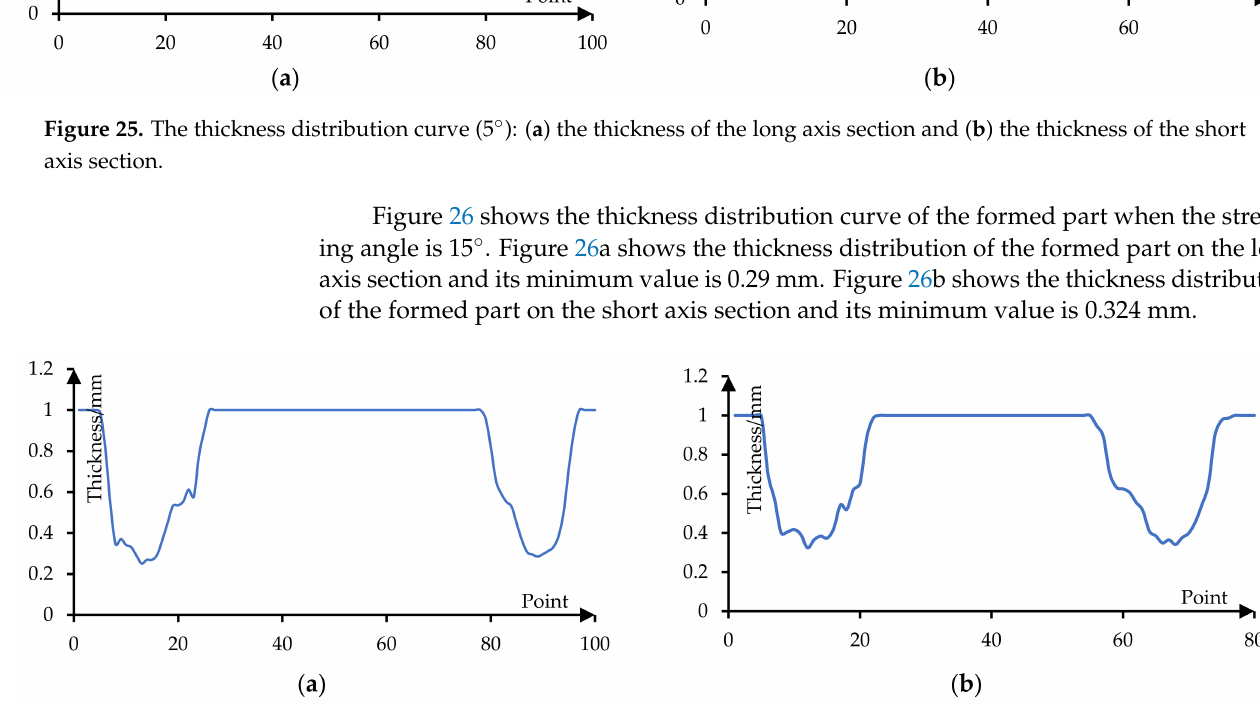
Figure 26. The thickness distribution curve (15 ◦ ): ( a ) the thickness of the long axis section and ( b ) the thickness of the short axis section.